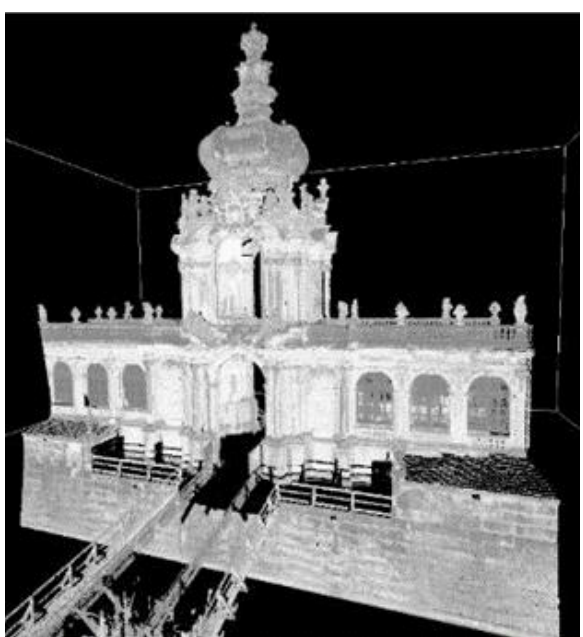
Figure 12. Point cloud based on terrestrial laser scanner